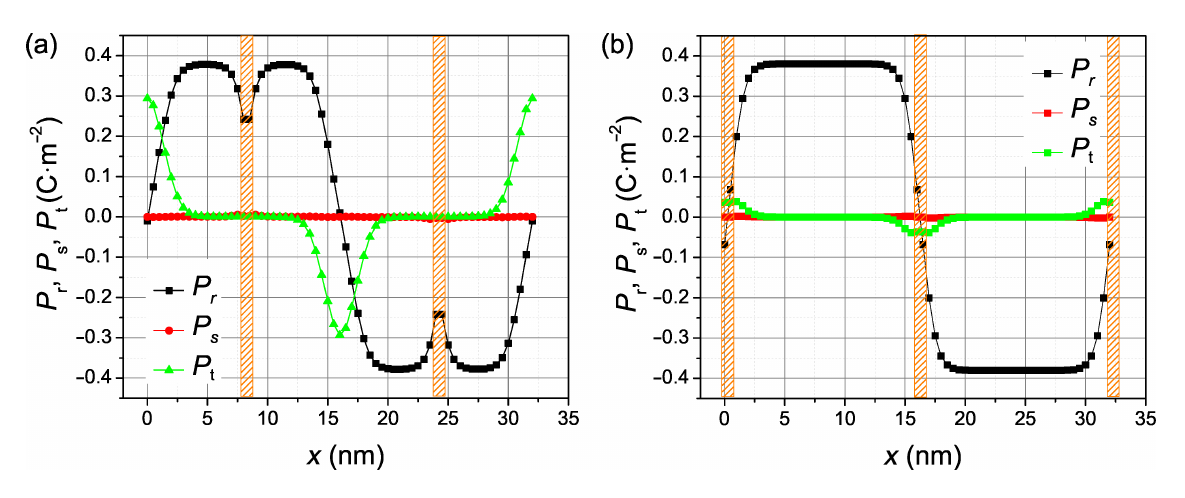
Figure 5: Relaxed profile of the polarization components across 180-degree ferroelectric walls in rhombohedral BaTiO 3 intercalated with 1 nm thin layers of SrTiO 3 . (a) SrTiO 3 layer within the ferroelectric domain. (b) SrTiO 3 layer located at the ferroelectric domain wall.